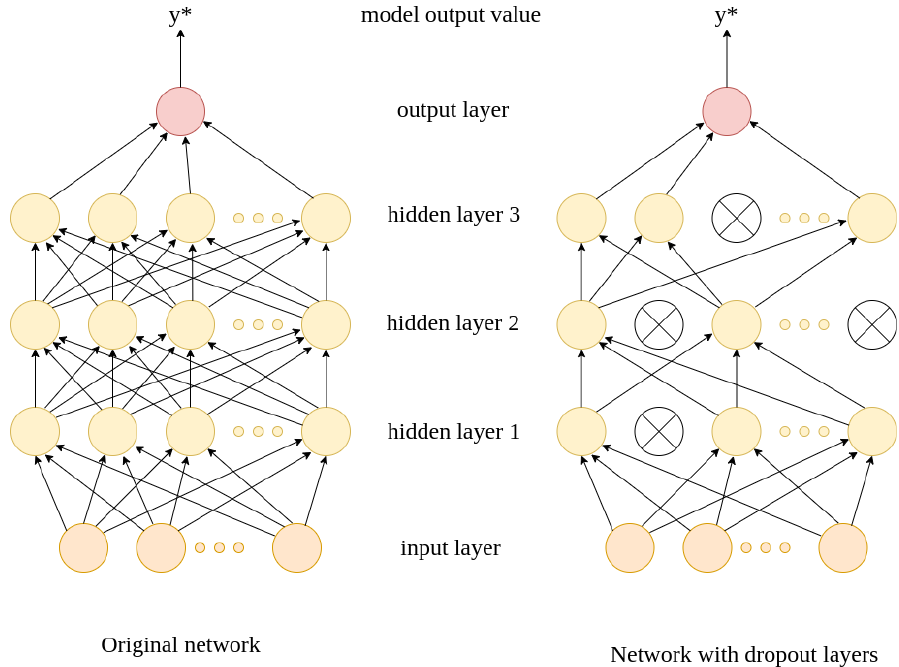
Figure 4. Neural network structure ( left ) with and ( right ) without dropout